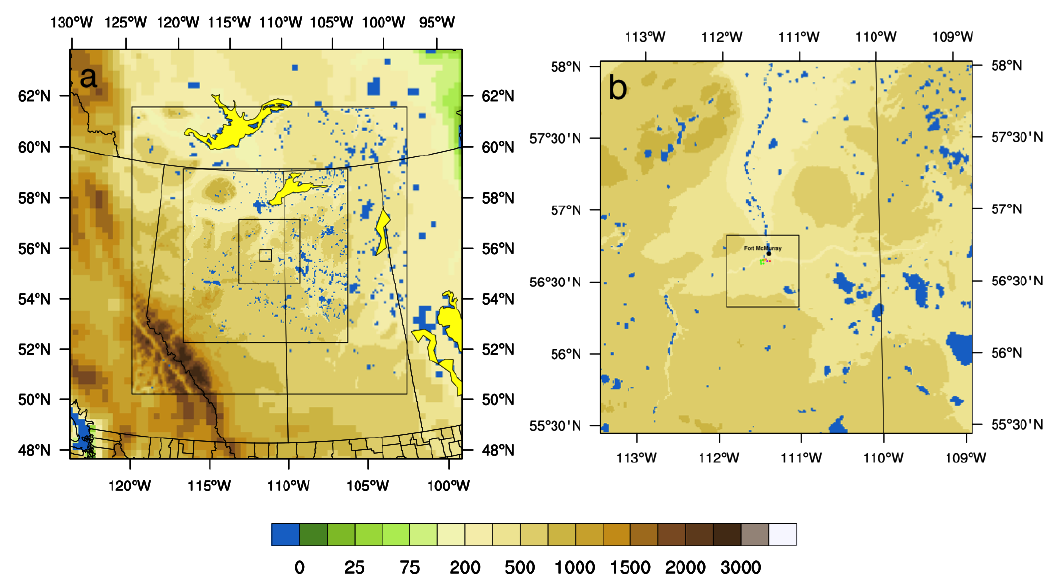
Figure 1. ( a ) The left figure shows five WRF domains and ( b ) the right figure shows two inner domains. The inner domain also presents the fire domain. The background color represents the elevation map, lakes are represented in solid yellow and the blue color shows the surface waters including